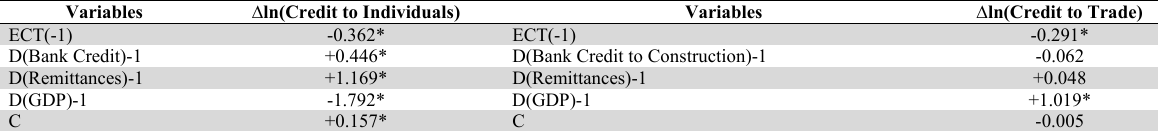
Results of the Vector Error Correction Models (VECM)